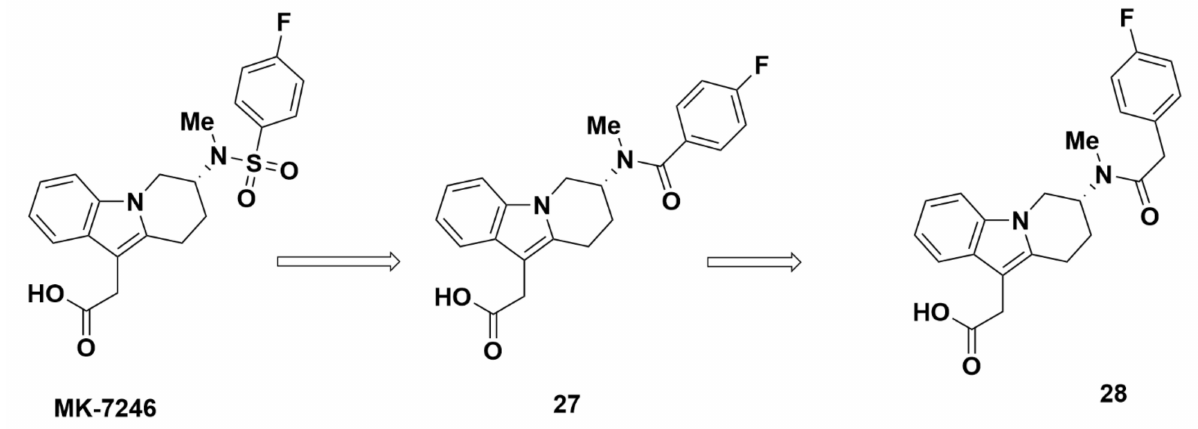
Figure 8. Molecular structures of compounds 27 and 28